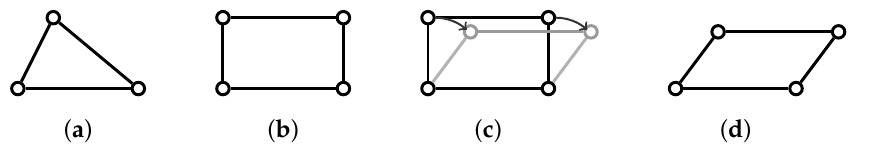
Figure 1. A rigid ( a ) and a flexible ( b ) framework in the plane. The motion shown in ( c ) takes the framework in ( b ) to the framework in ( d